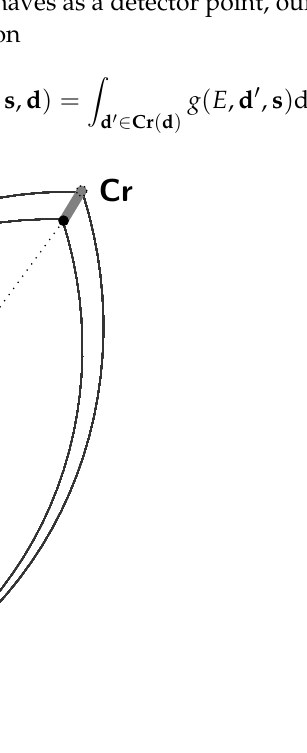
Figure 5. The size and shape of the crystal implies the integration along a beam of circular-arcs and not only one pair (when the crystal is assumed to be a point)